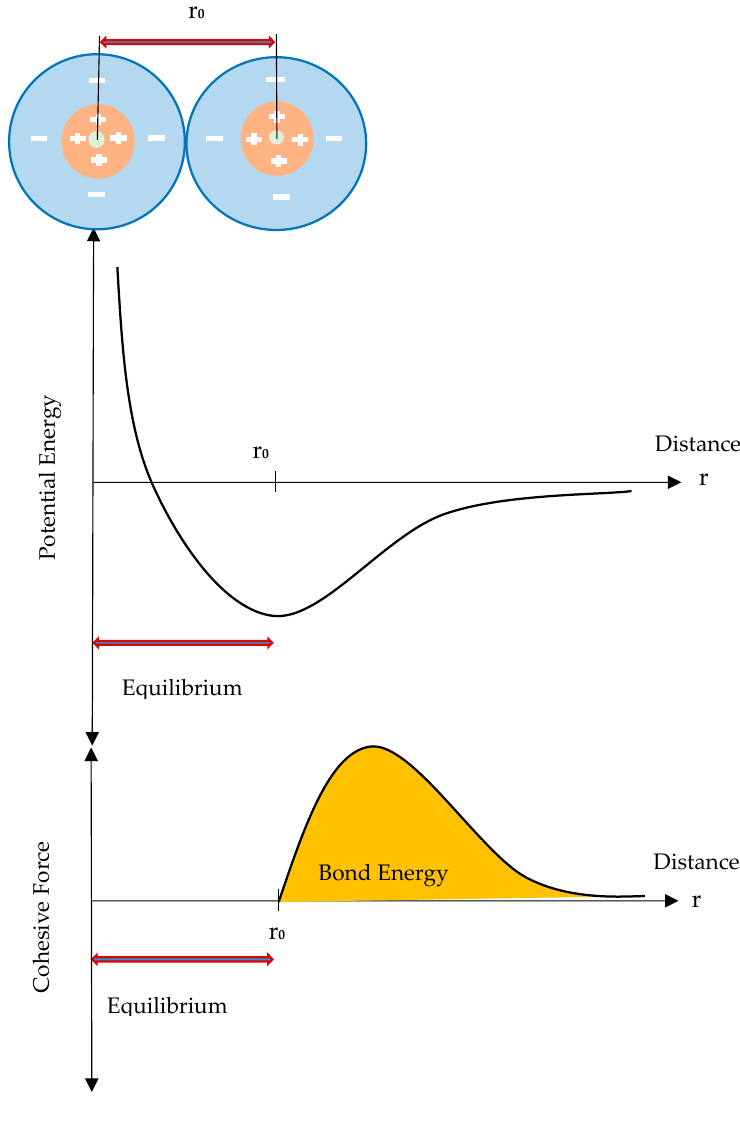
Figure 1. Variation of the potential energy and the cohesive force during separation of two atoms from each other.